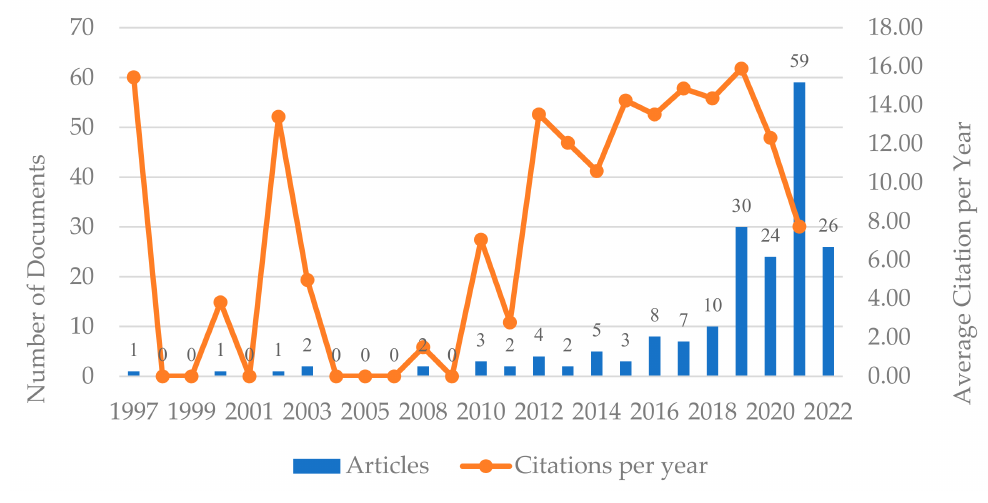
Figure 1. Annual number distribution and